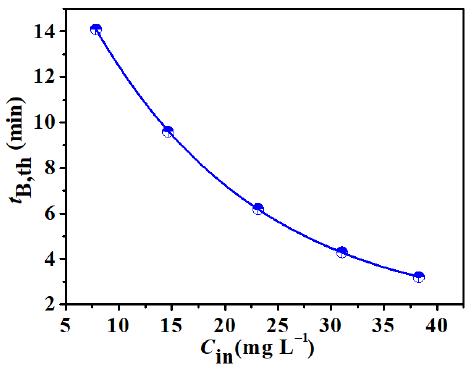
Figure 8. Effect of inlet concentration on breakthrough time.